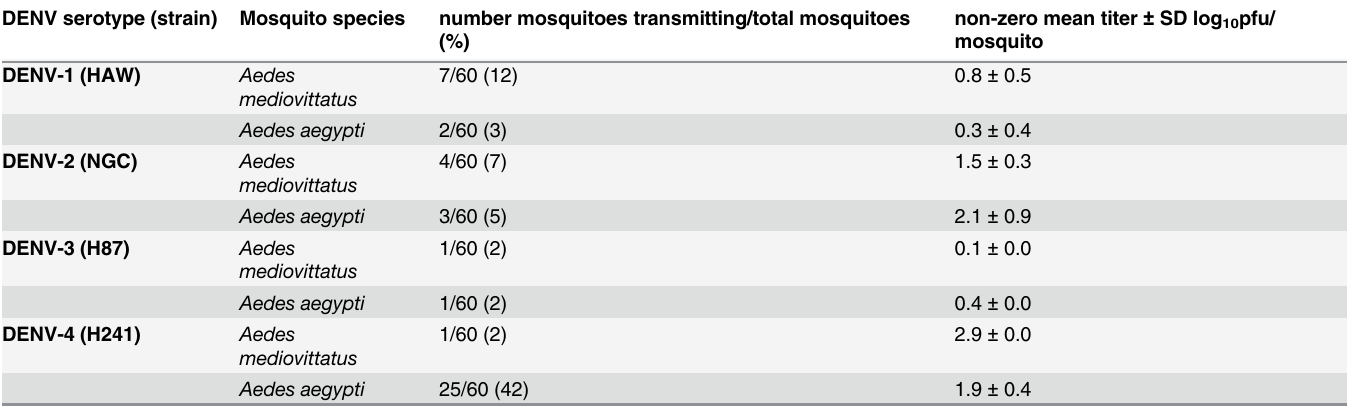
Table 2. Transmission rates and saliva titers of Aedes mediovittatus and Aedes aegypti mosquitoes 14 days post bloodmeal. DENV serotype (strain) Mosquito species